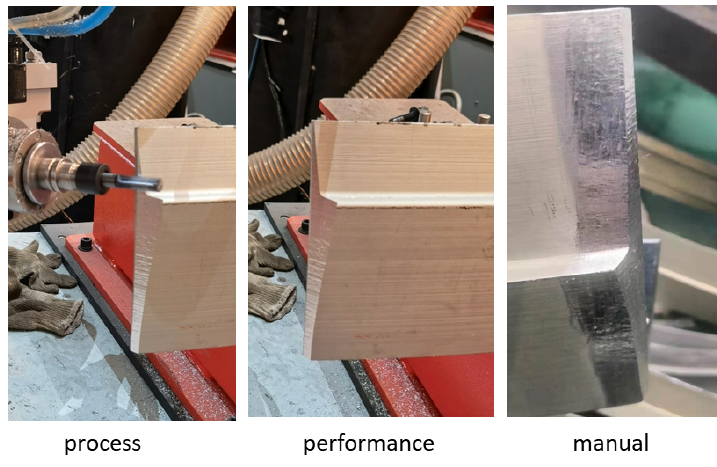
Figure 18. Comparison effects of the robot bevel milling processing result and manual bevel process- ing result.